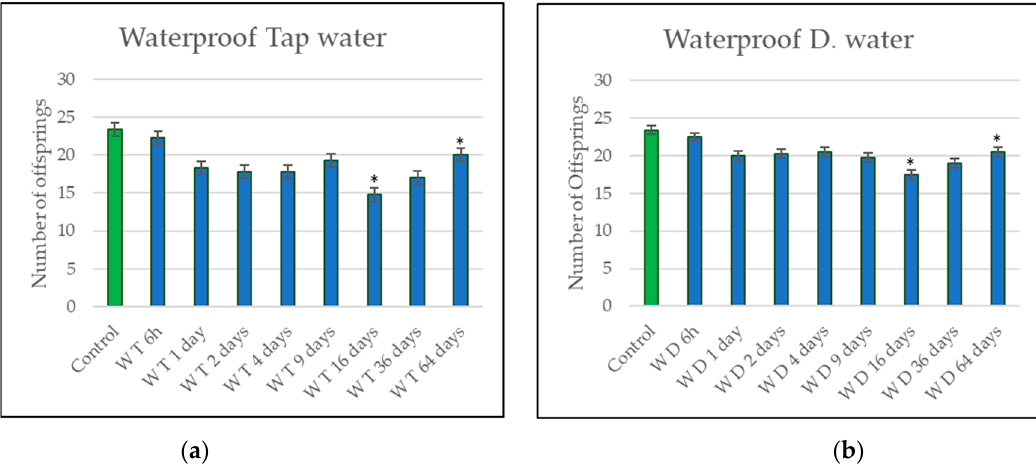
Figure 4. ( a ) Enchytraeid reproduction results for eluates from the waterproof material using tap water. ( b ) Enchytraeid reproduction results for eluates from the waterproof material using distilled water. Significant results are marked with an (*).